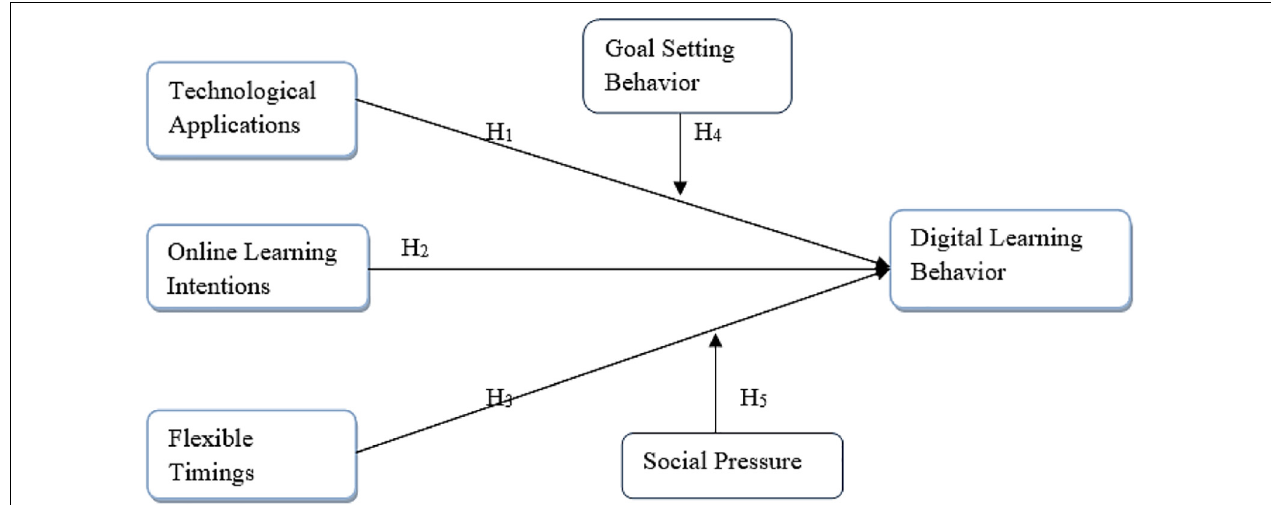
FIGURE 1 | Conceptual